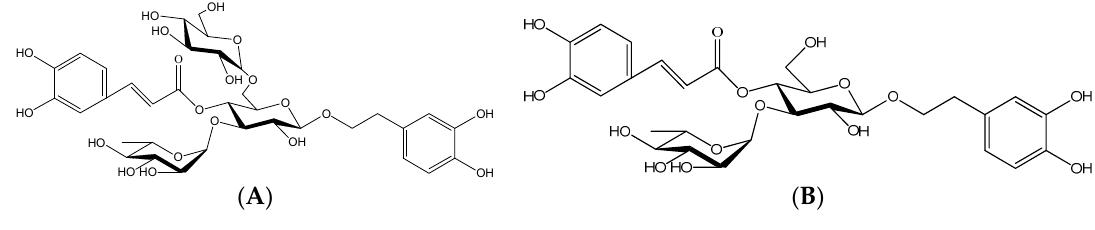
Figure 9. Structures of echinacoside ( A ) and acteoside ( B ).